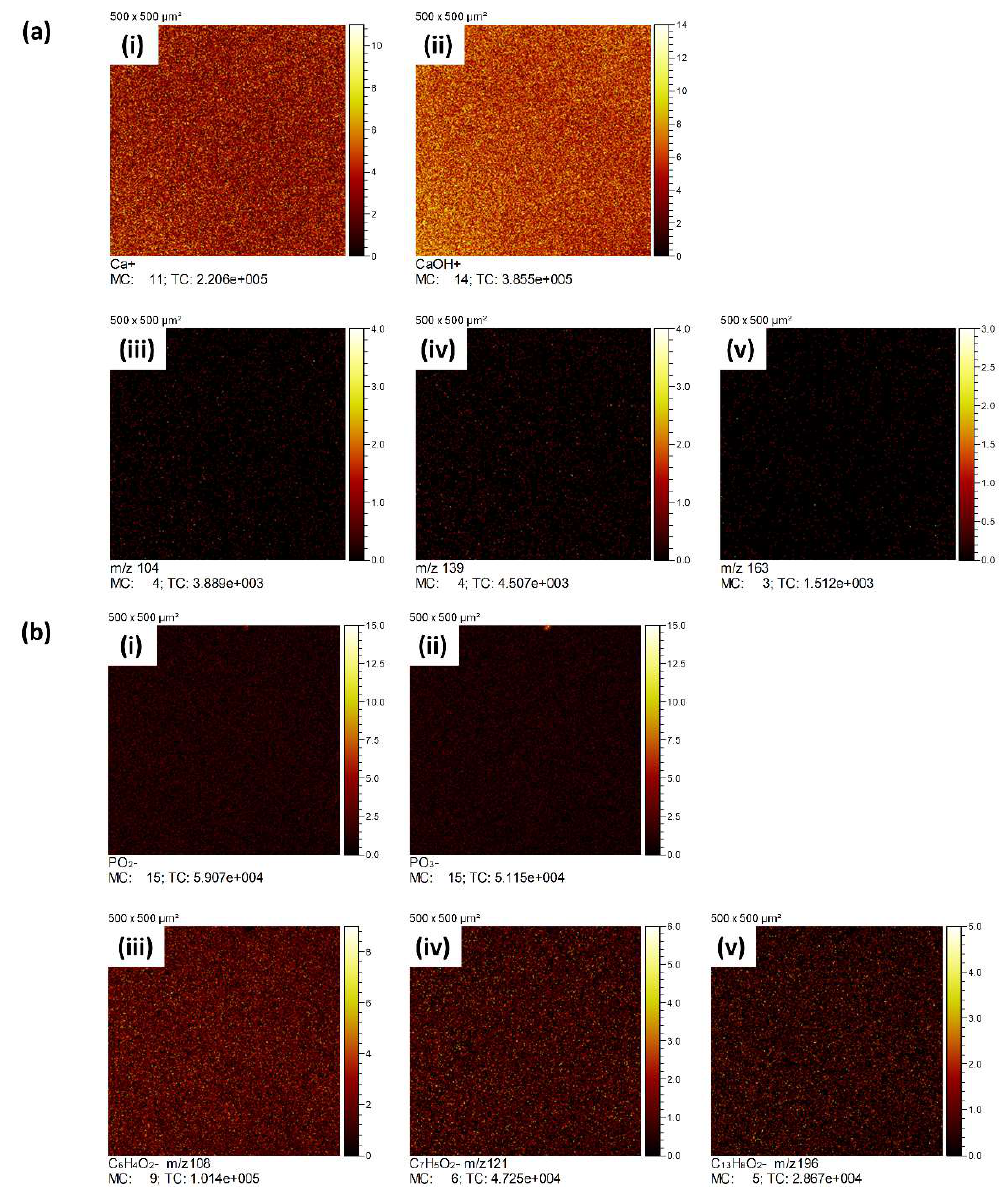
Figure 13. ( a ) ToFSIMS positive ion intensity surface maps for HA600 obtained at selected masses (i) Ca + , (ii) CaOH + , (iii) m / z 104, (iv) m / z 139 and (v) m / z 163. All images were normalised to the total ion count; ( b ) ToFSIMS negative ion intensity surface maps for HA600 obtained at selected masses (i) PO 2 − , (ii) PO 3 − , (iii) C 6 H 4 O 2 − , 108 (iv) C 7 H 5 O 2 − 121, and (v) C 13 H 8 O 2 − 196). All images were normalised to the total ion count.